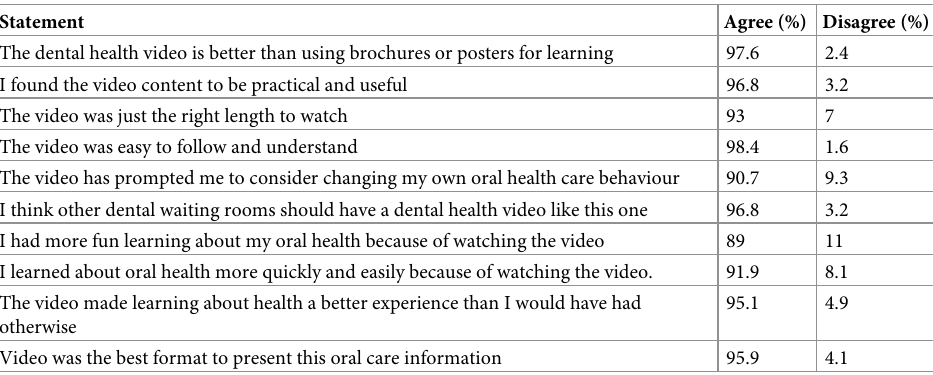
Table 2. Evaluation of video